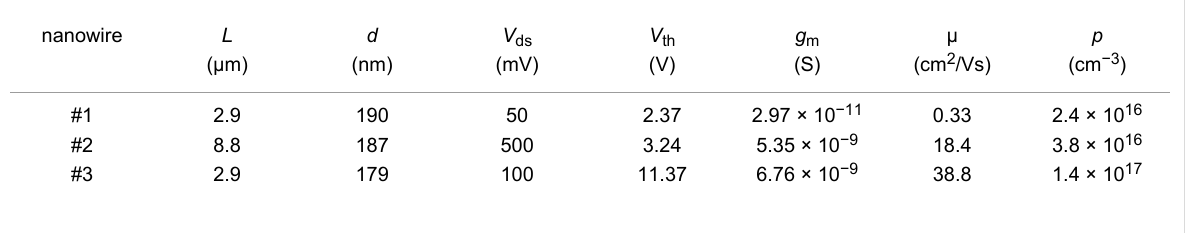
Table 1: Summary of the channel length ( L ), average nanowire diameter ( d ), threshold voltage ( V th ), transconductance ( g m ), hole mobility ( μ ) and free hole concentration ( p ), for three assembled FETs based on nanowires from sample